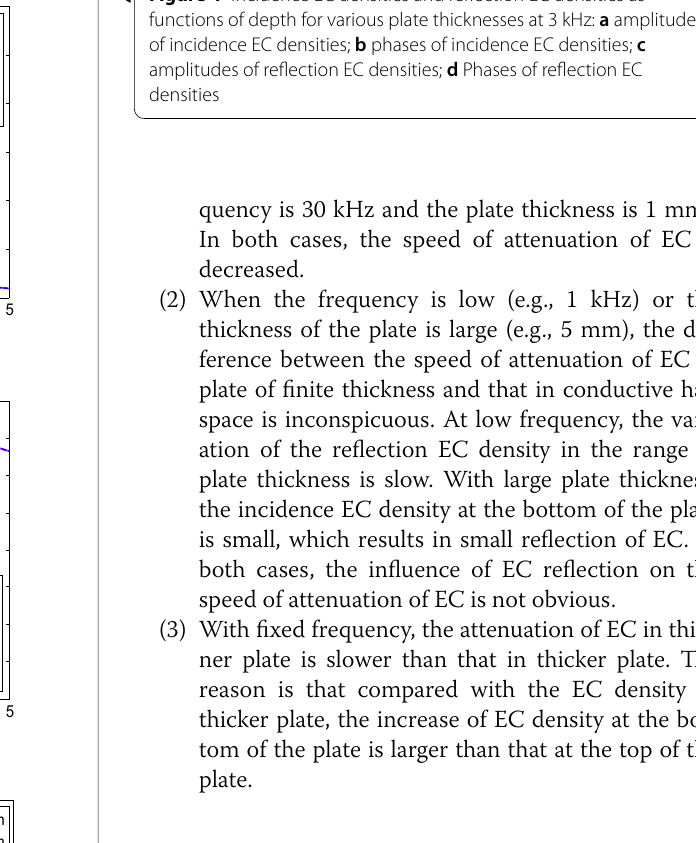
Figure 4 Incidence EC densities and reflection EC densities as functions of depth for various plate thicknesses at 3 kHz: a amplitudes of incidence EC densities; b phases of incidence EC densities; c amplitudes of reflection EC densities; d Phases of reflection EC densities